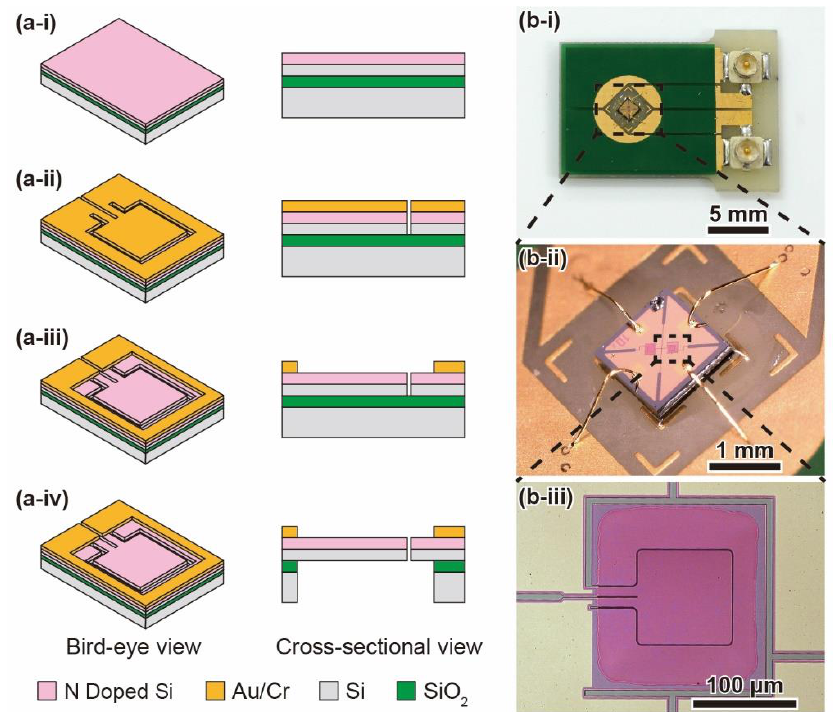
Figure 4. Fabrication process of the piezoresistive cantilever and photographs of the fabricated sensor chip and the cantilever. ( a-i ) Forming an N-type piezoresistive layer on the device Si layer of a silicon-on-insulator (SOI) wafer. ( a-ii ) Depositing a Au/Cr layer and etching the device Si layer. ( a-iii ) Patterning the Au/Cr layer. ( a-iv ) Etching the handle Si/SiO 2 layers. Photographs of ( b-i ) the sensor element, ( b-ii ) the sensor chip, and ( b-iii ) the piezoresistive cantilever.